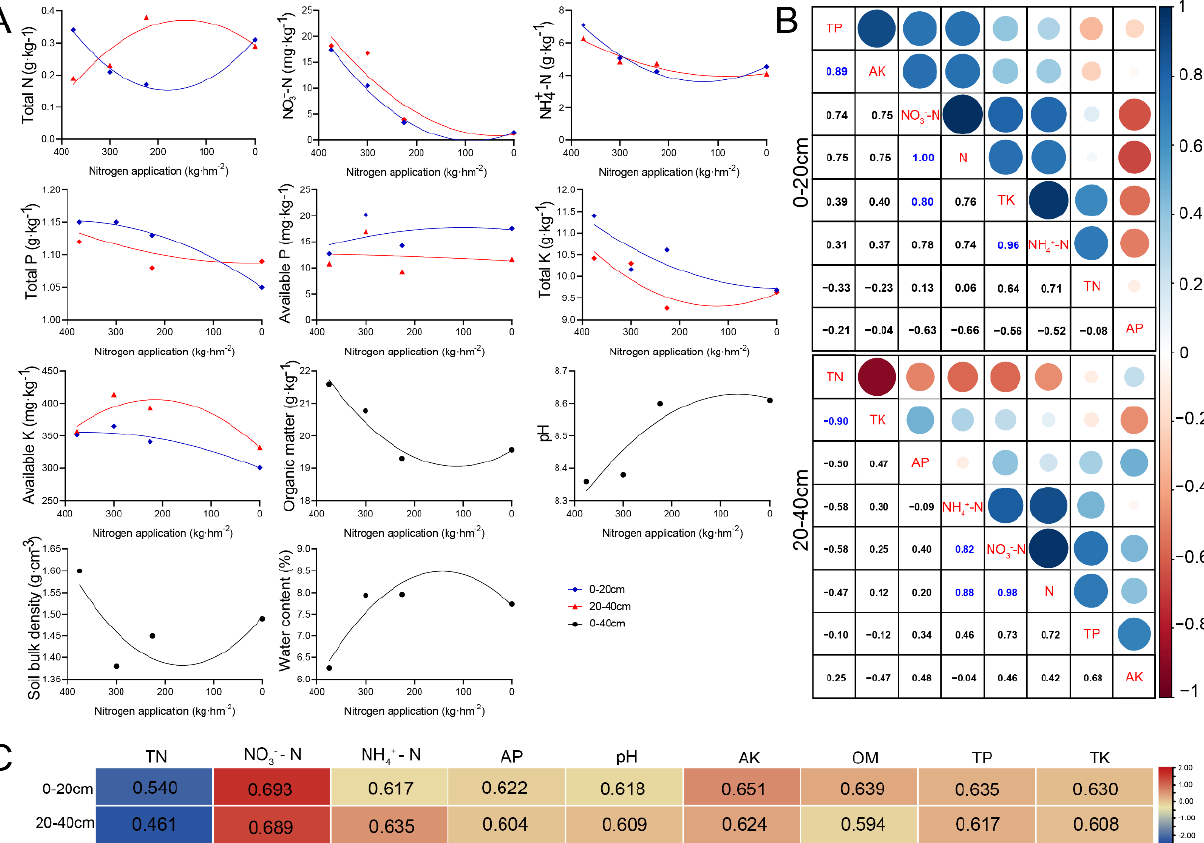
Figure 1. Soil nutrient and correlation analysis. ( A ) Variation in soil nutrient content of different RNE treatments. Blue represents 0–20 cm soil. Red represents 20–40 cm soil. Black represents 0–40 cm soil. Fitting was performed using ordinary least square. ( B ) Correlation between different nutrients. Blue represents positive correlation. Red represents negative correlations. The size of the circles represents the level of correlation. Correlations were calculated using Pearson’s coefficient. ( C ) Grey relational analysis of different nutrients with RNE. A redder color represents higher correlation.